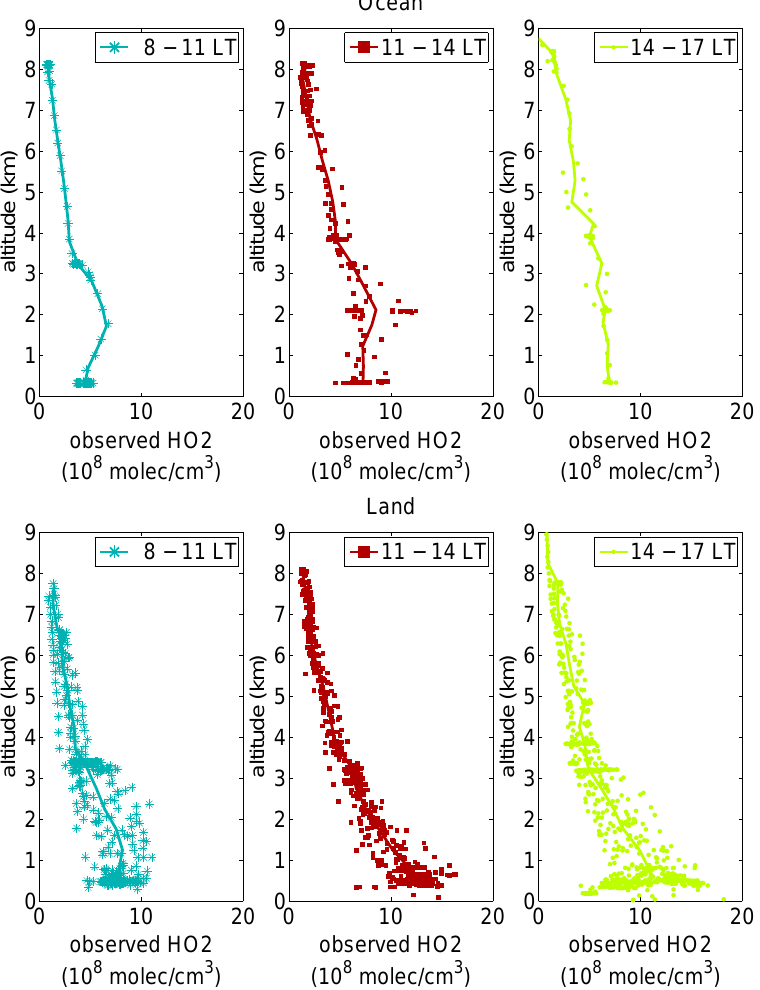
Fig. 3. HO 2 (30 s average) observed for all flights as a function of altitude. The thick line denotes the mean values in 500 m bins. Upper row represents the situation over the ocean for different times of the day (left to right panel), lower row shows the situation over land.